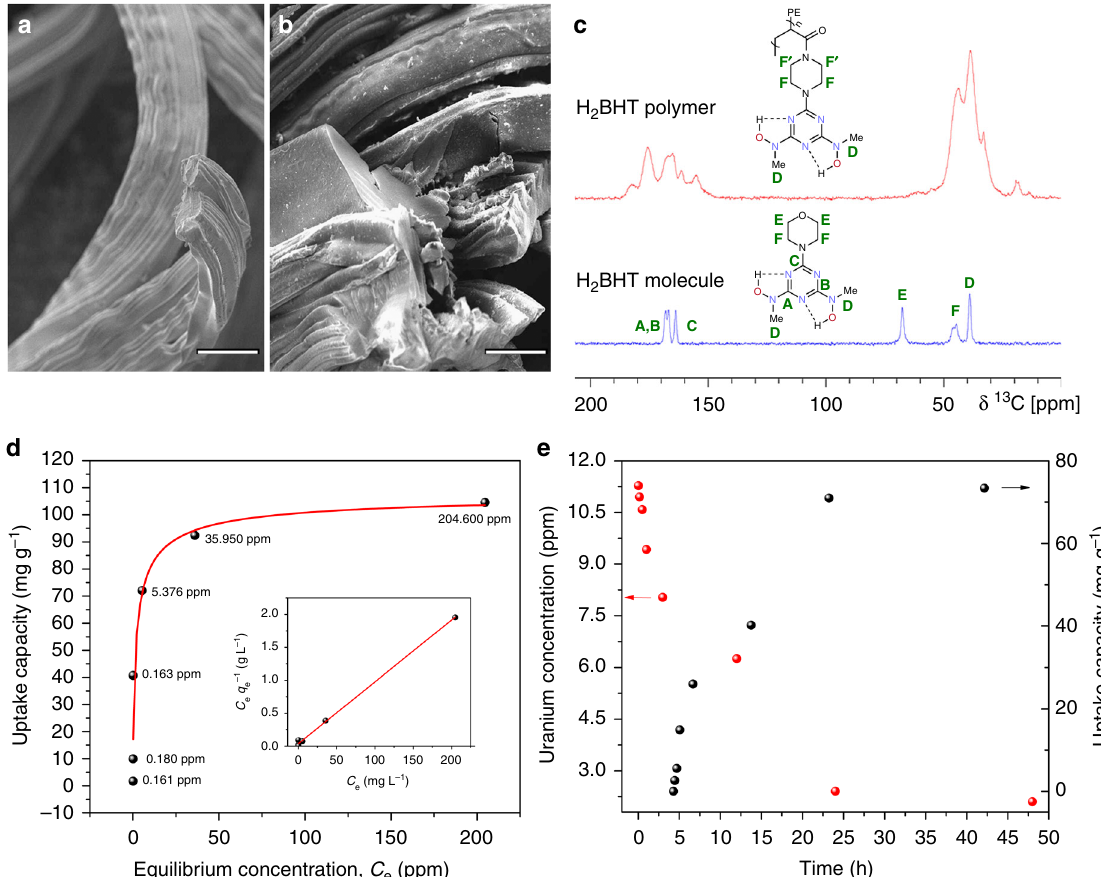
Fig. 3 Characterization and performance of the H 2 BHT polymeric adsorbent. a , b SEM images for the starting material (polyethylene-graft-polyacrylic acid) and the H 2 BHT adsorbent, respectively. Scale bars, 50 µ m. c δ 13 C CP/MAS solid-state NMR spectra of H 2 BHT polymer and H 2 BHT ligand spun at 15 kHz. d Uranium sorption isotherm (inset displays the linear regression by fi tting the equilibrium data with the linear form of the Langmuir adsorption model). All the fi ts (red lines) have R 2 values higher than 0.98. The equilibrium concentration (ppm) of uranyl ions is given for each data point. e Kinetics of uranium removal from aqueous solution with an initial concentration (10 ppm, 400 mL) at pH ~6, and adsorbent material (5